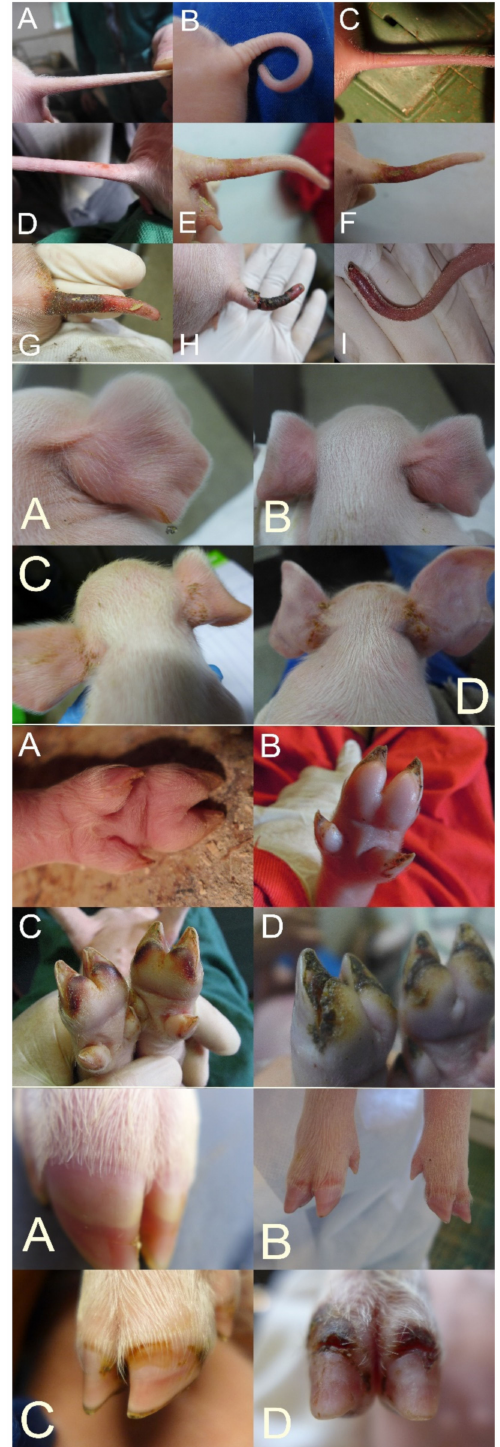
Figure 1. This figure shows, arranged one below the other and separated by yellow lines, different degrees of inflammation and necrosis of the tail (top, ( A – I )), ears (middle top, ( A – D )), claws, heels and soles (middle bottom, ( A – D )), and coronary bands (bottom, ( A – D )) in three-day-old piglets. Photos marked A show the physiological state without SINS. Inflammation and necrosis of the tail: ( A ) Intact tail; no swelling, no redness, no deposits or exudation and full bristles. ( B ) First stage of change: bristle loss and swelling. ( C ) Redness is added. ( D – G ) Various degrees of tail base inflammation